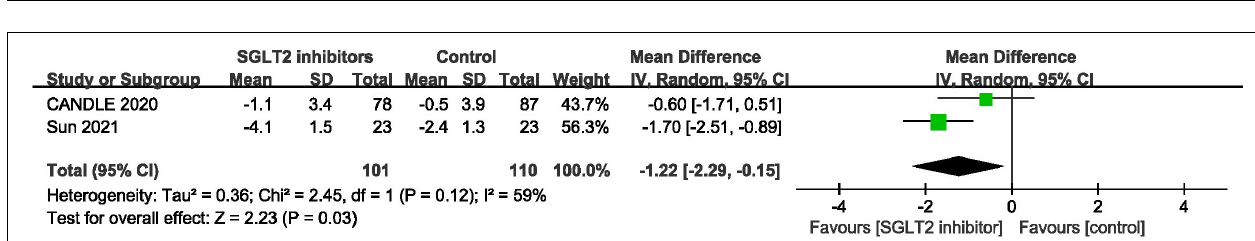
Frontiers in Cardiovascular Medicine |